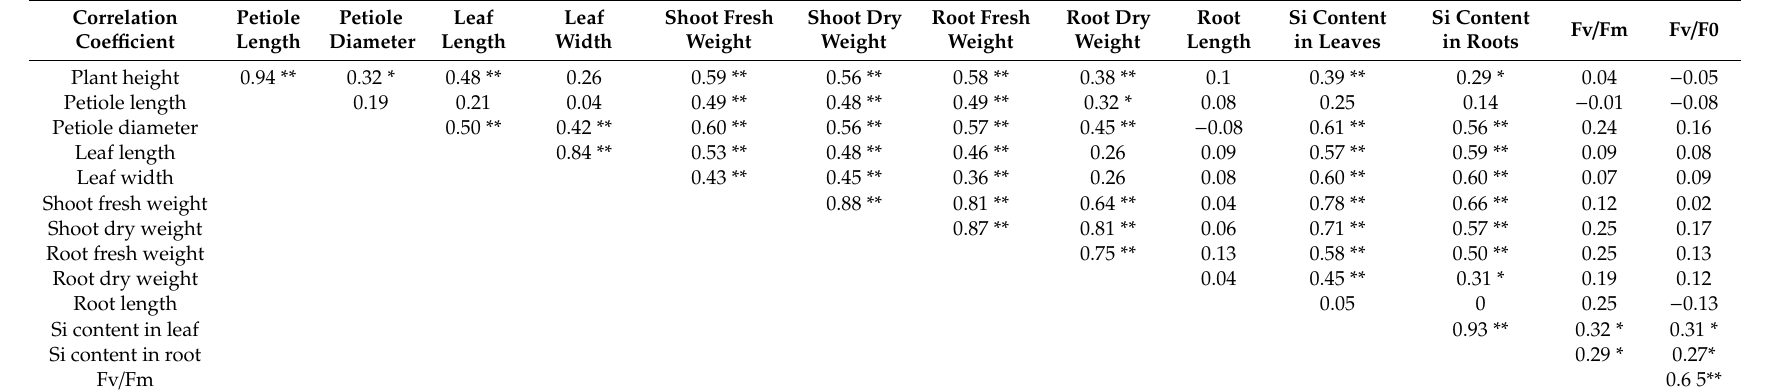
Table 2. Correlation analysis between di ff erent parameters measured in this